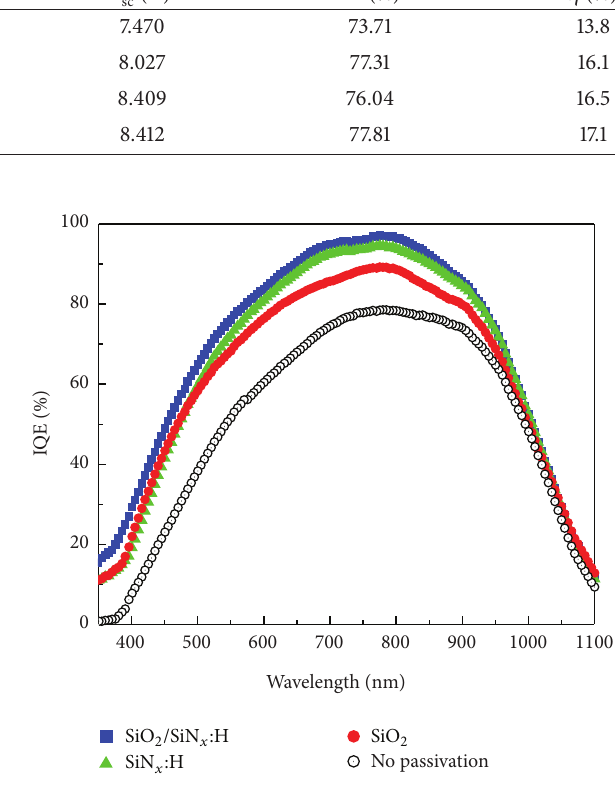
Figure 5: Internal quantum efficiency (IQE) spectra of the b-Si solar cell and b-Si solar cells with SiO 2 , SiN passivation